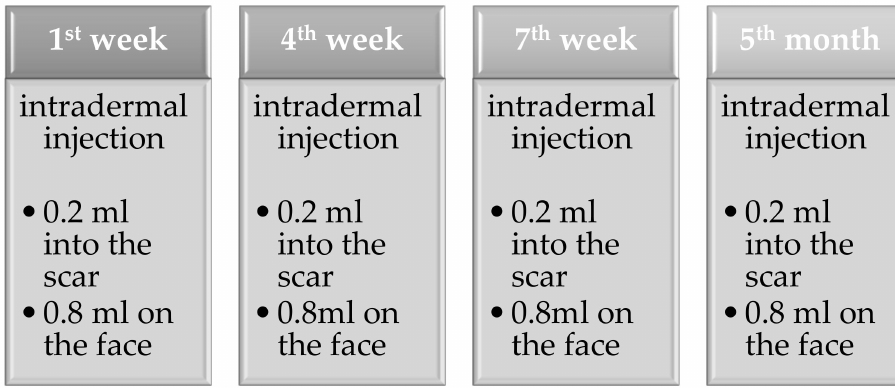
Figure 2. The general scheme of the treatment.